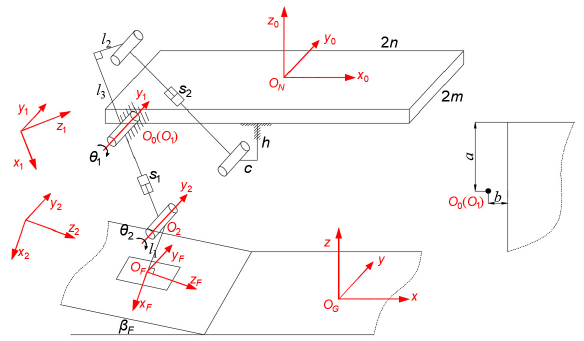
Figure 3. Kinematics model of dredging robot.